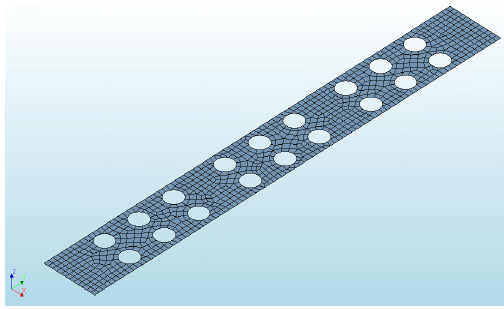
Figure 8. The interface surface (bond) between concrete layers. The finite elements of the slab are 0.02 × 0.02 m in size. The structure was calculated by performing nonlinear analysis and using the arch length control method